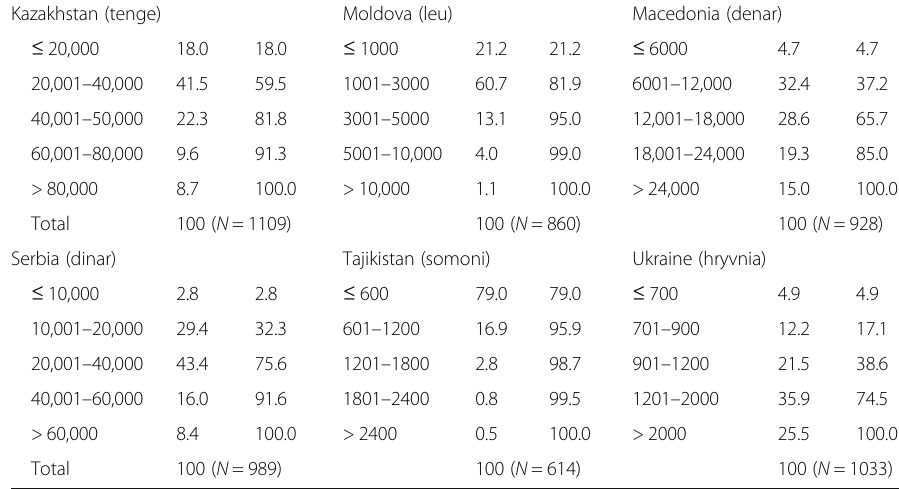
Table 3 Total monthly income data: original intervals and percentage of workers in each interval Kazakhstan (tenge) Moldova (leu) Macedonia (denar) ≤